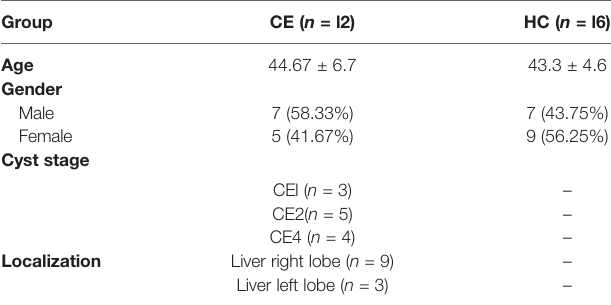
TABLE 2 | Characteristics of the study subjects.